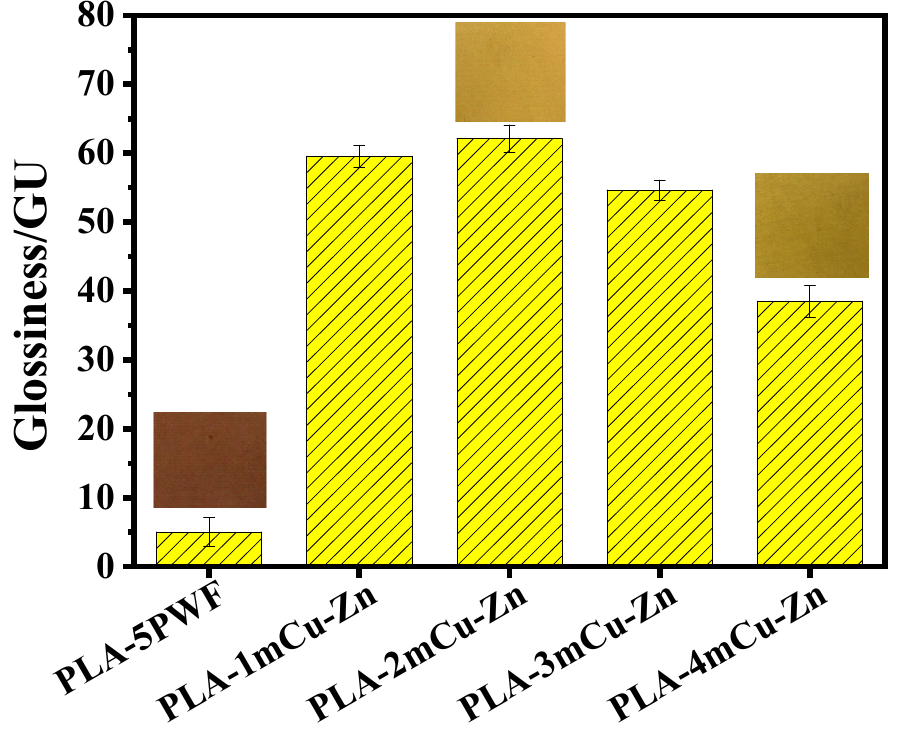
Figure 12. The gloss value of PLA ‐ 5PWF and mCu ‐ Zn/PWF/PLA composites with 5 wt.% PWF.